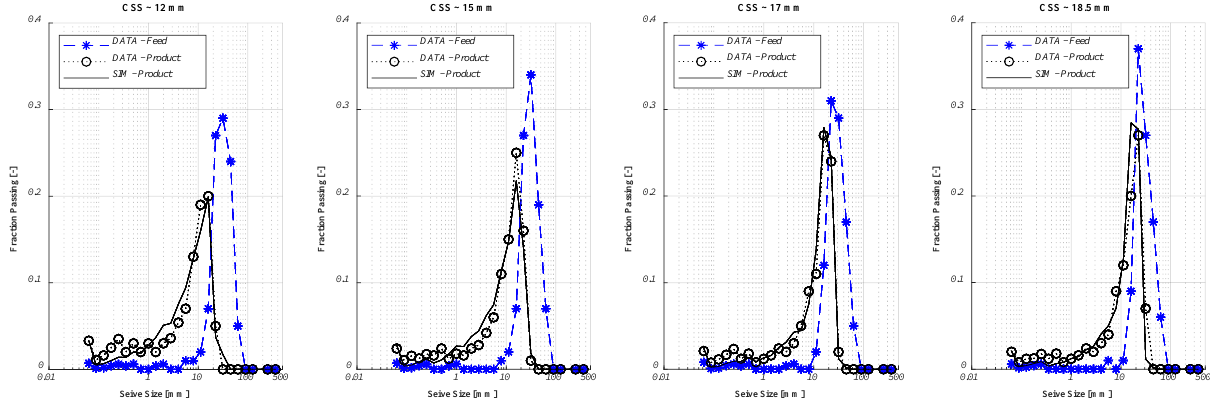
Figure 10. Crusher calibration result to the belt-cut experimental data in the frequency domain.